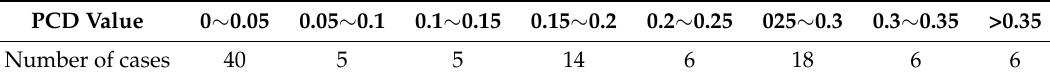
Figure 5. 2D contour plot of PCD values as a function of time step for 100 independent simulation experiments of VFA-SF. Table 1. The statistical analysis of final PCD value from 100 independent